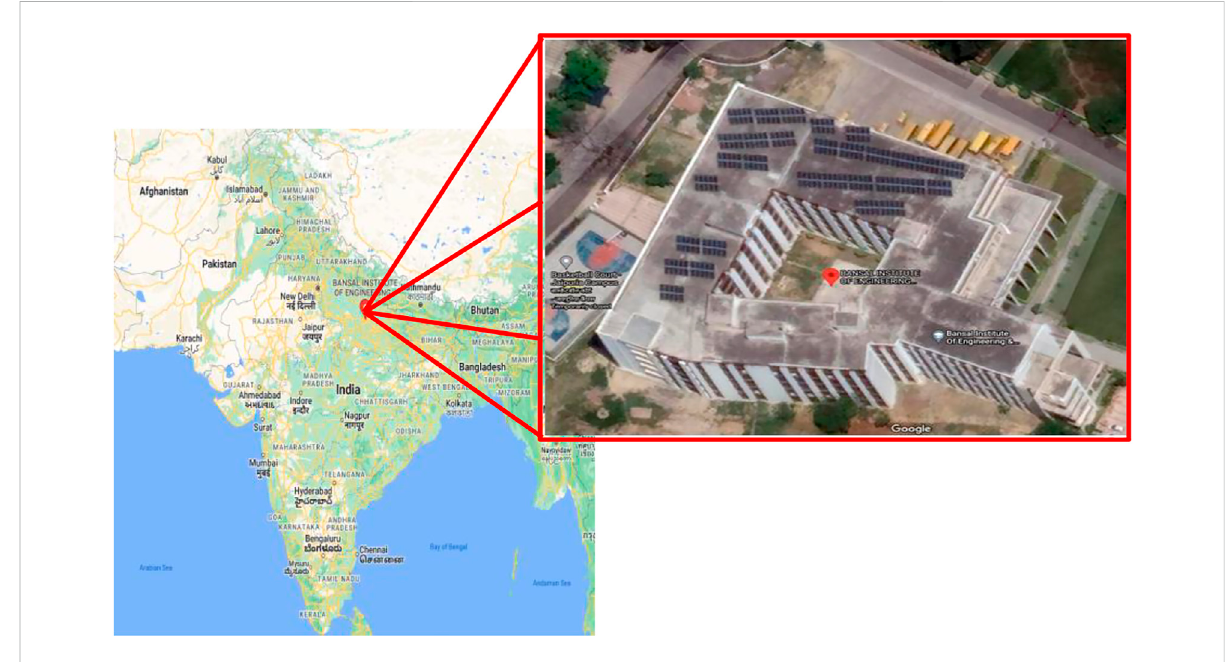
FIGURE 1 Location of the 100 kW grid-tie plant at Indian Map (Google, 2022).